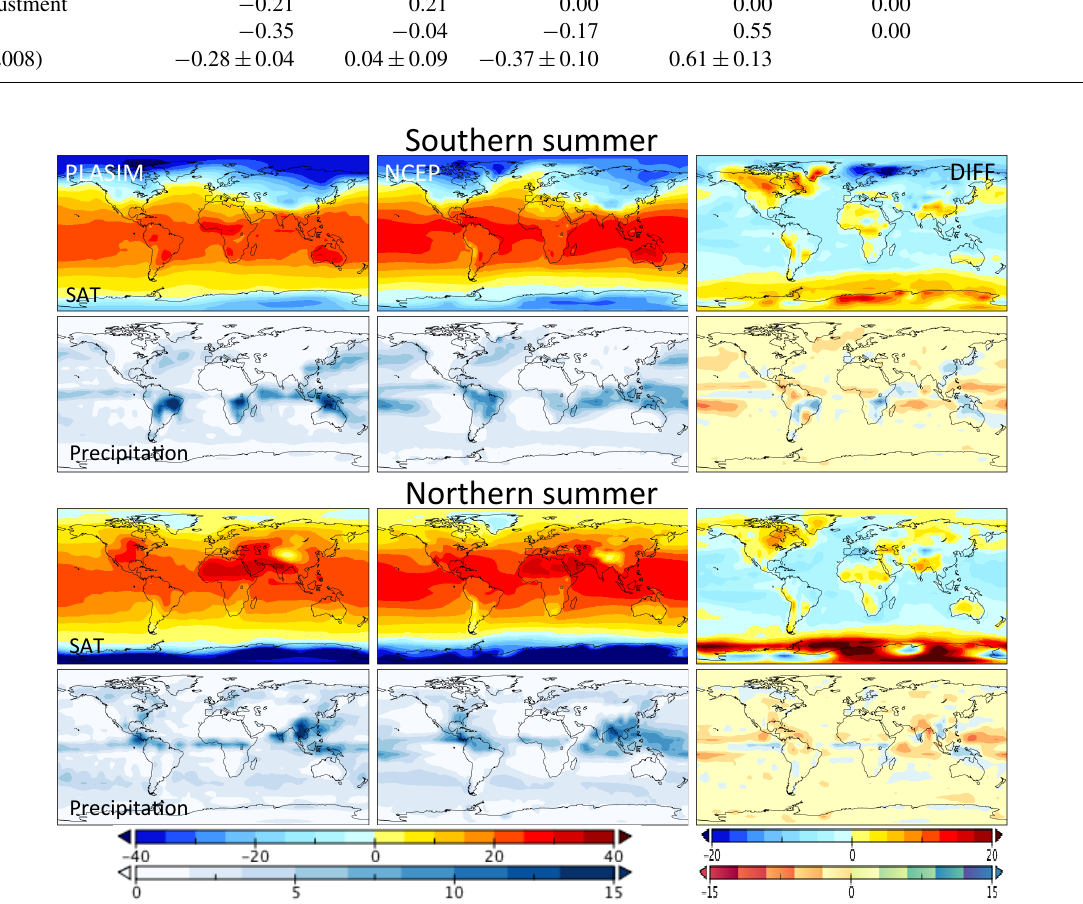
Figure 2. Seasonal surface air temperature ( ◦ C) and precipitation (mmday − 1 ). Left: PLASIM–GENIE 50-year average; centre: long-term average (1981–2010) NCEP/NCAR reanalysis fields (Kalnay et al., 1996); right: difference